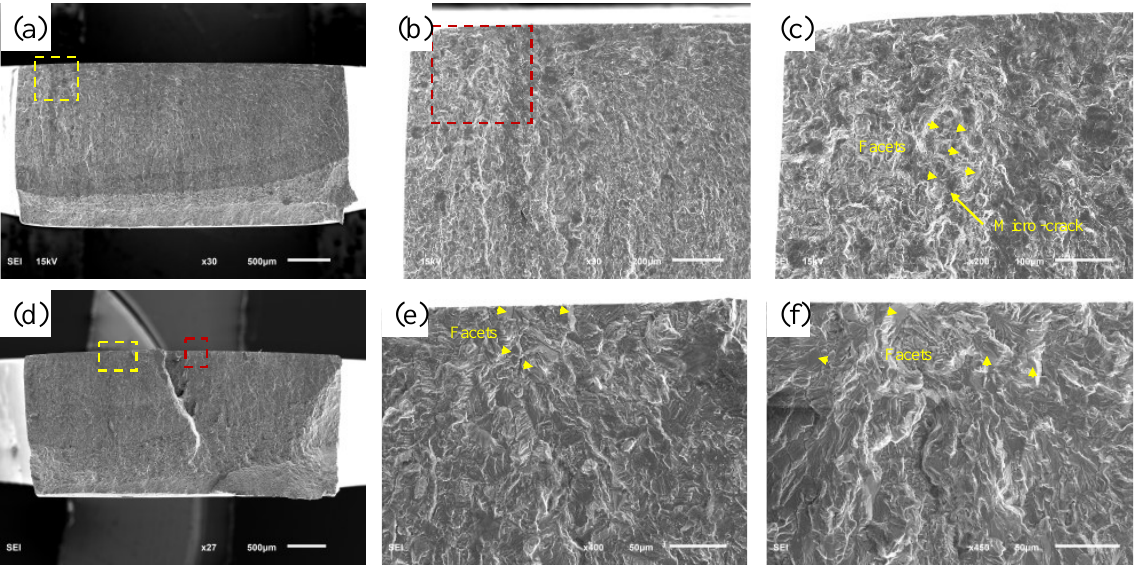
MPa, cy- Figure 10. Typical fracture morphology in the HCF: ( a , b,c ) Figure 10. Typical fracture morphology in the HCF: ( a – c ) σ a = 390.14 MPa, N f = 3.39 × 10 5 cycles; 5 MPa, cycles. cles; ( c , d , f ) 𝜎𝜎 𝑎𝑎 = 390.14 𝑁𝑁 𝑓𝑓 = 3.39 × 10 ( d – f ) σ a = 220.01 MPa, N f = 6.05 × 10 6 6 𝑁𝑁 𝑓𝑓 = 6.05 × 10 𝜎𝜎 𝑎𝑎 = 220.01